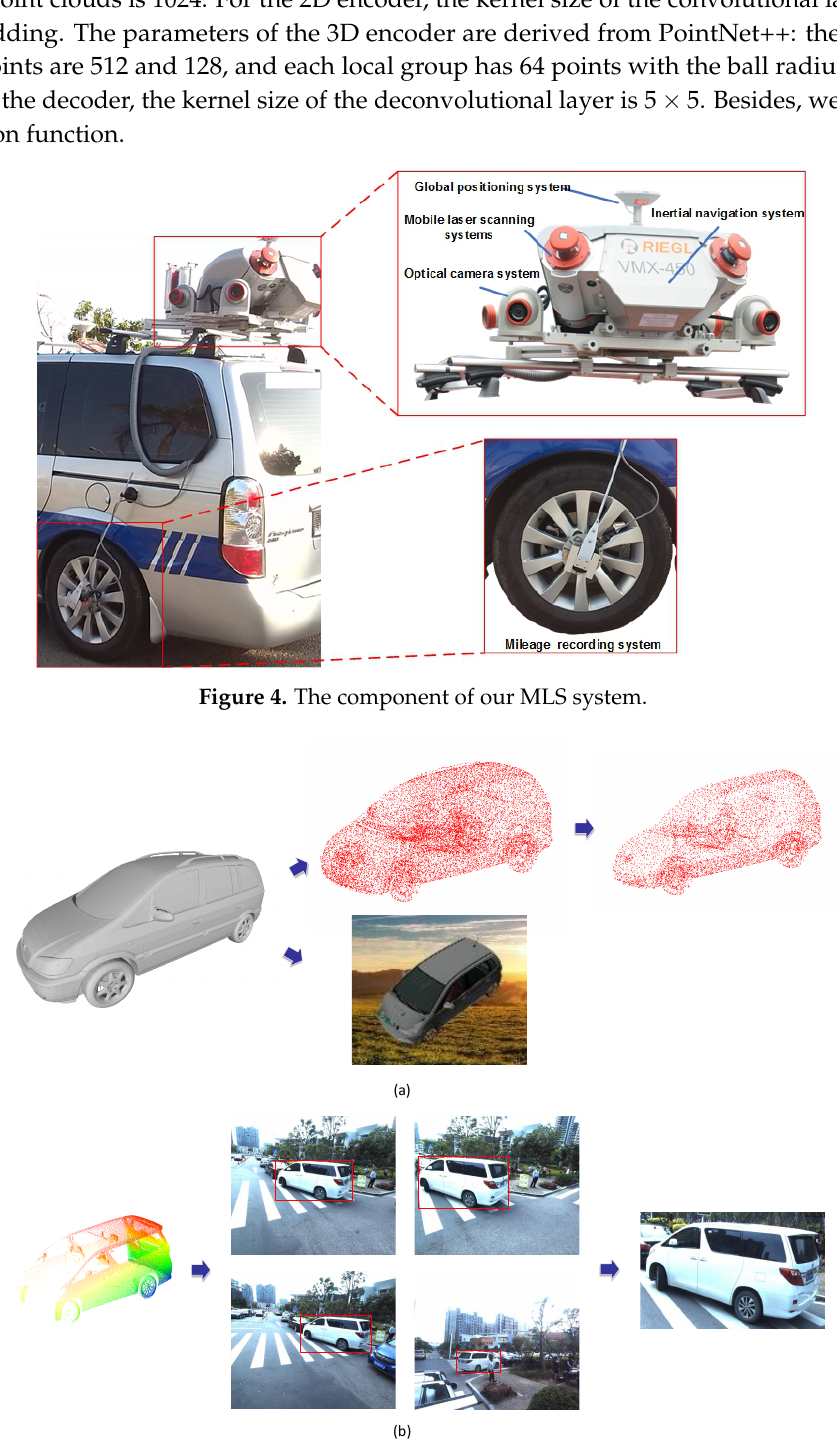
Figure 5. The procedure of making MLS